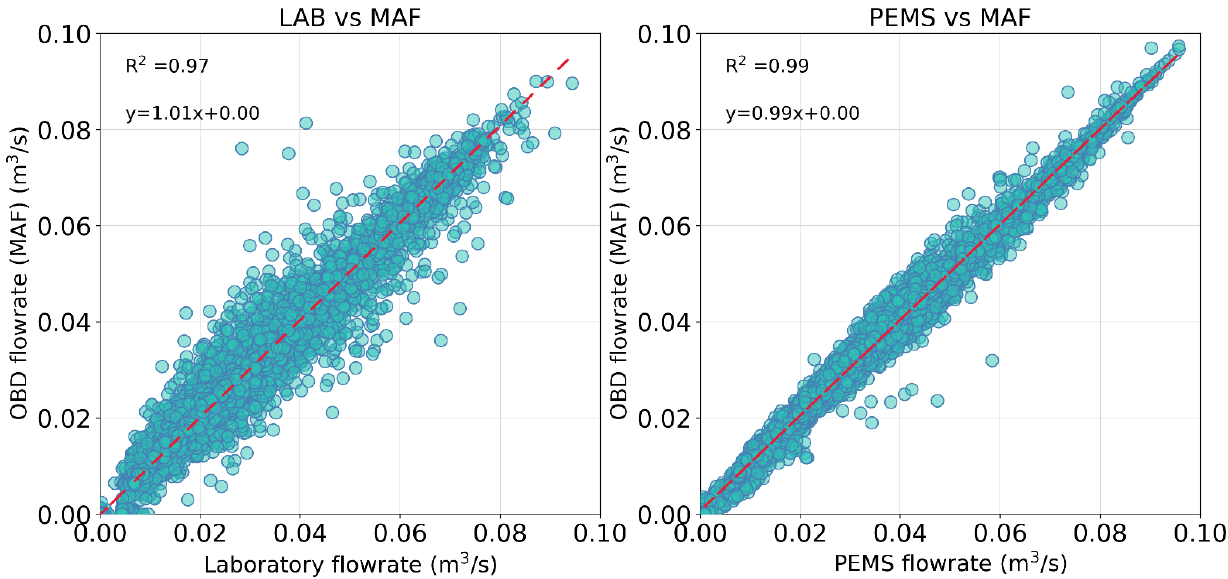
Figure 2. ( Left panel ) Correlation between MAF signal from OBD and flow rate measured in the laboratory (difference between CVS and dilution flow rate) from all the WLTC tests performed. ( Right panel ) Correlation between MAF and PEMS flow rate from all the on-road tests performed.